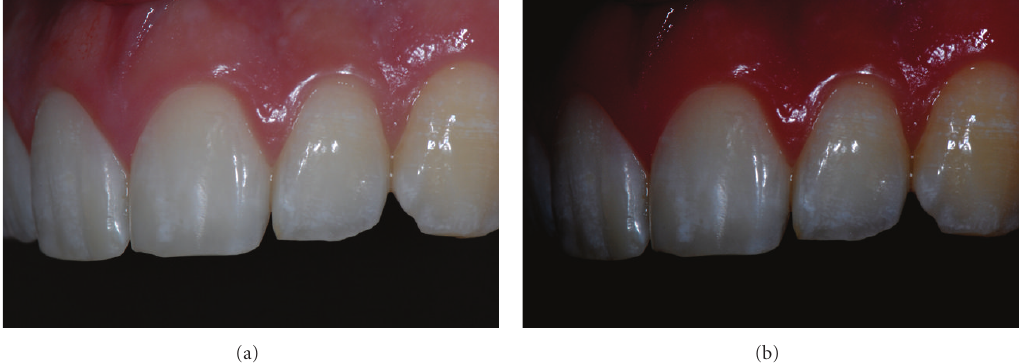
Figure 6: (a) Final left side picture. (b) Software-modified final left side